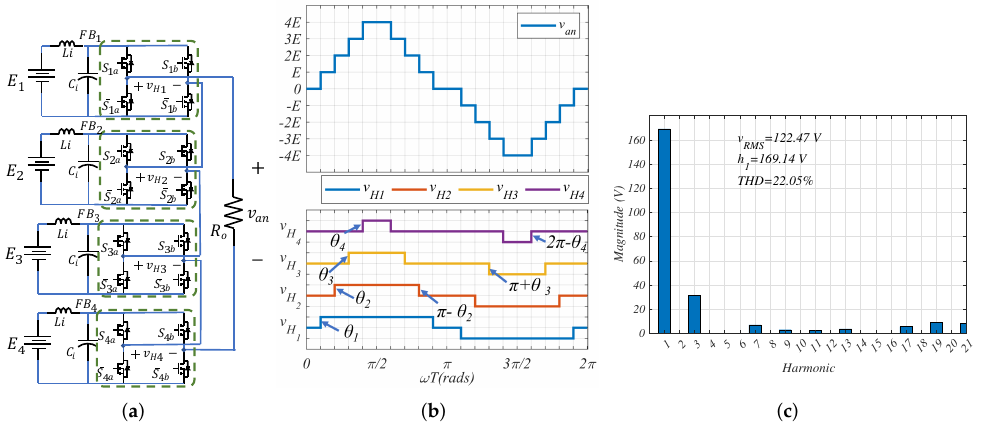
Figure 1. ( a ) Cascaded-Full-Bridge Multilevel Inverter with 4 FBCs, ( b ) Waveforms of v an , v H 1 , v H 2 , v H 3 and v H 4 , ( c ) harmonic analysis of v an